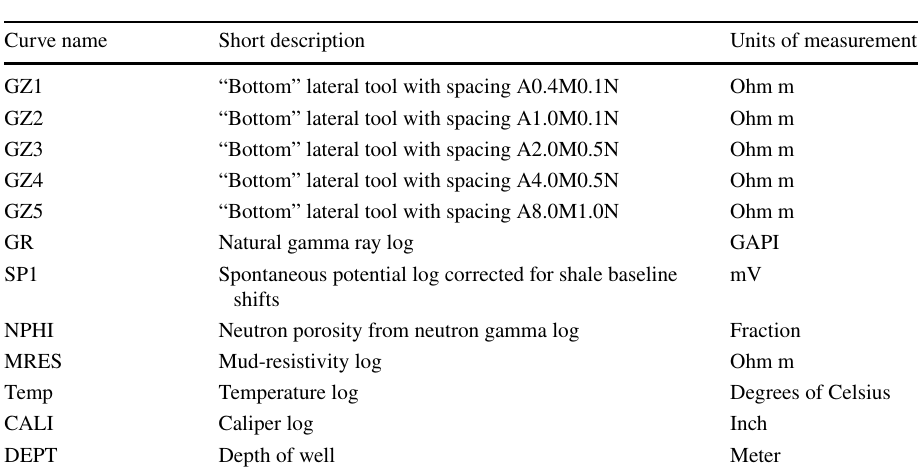
Table 1 Wireline curves’ description